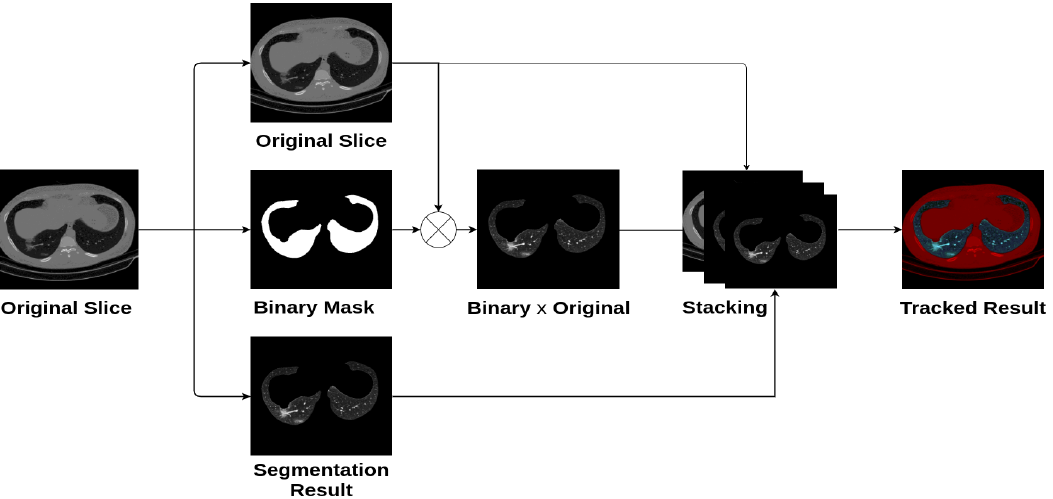
Figure 3. Preprocessing phase.